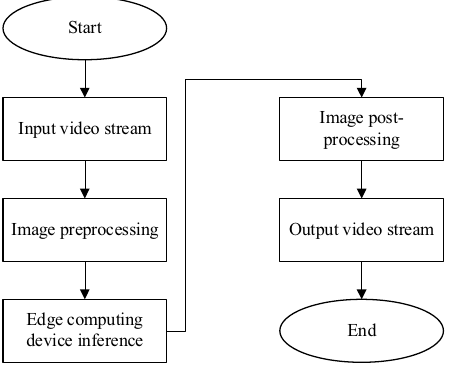
Fig. 1. System processing flow.